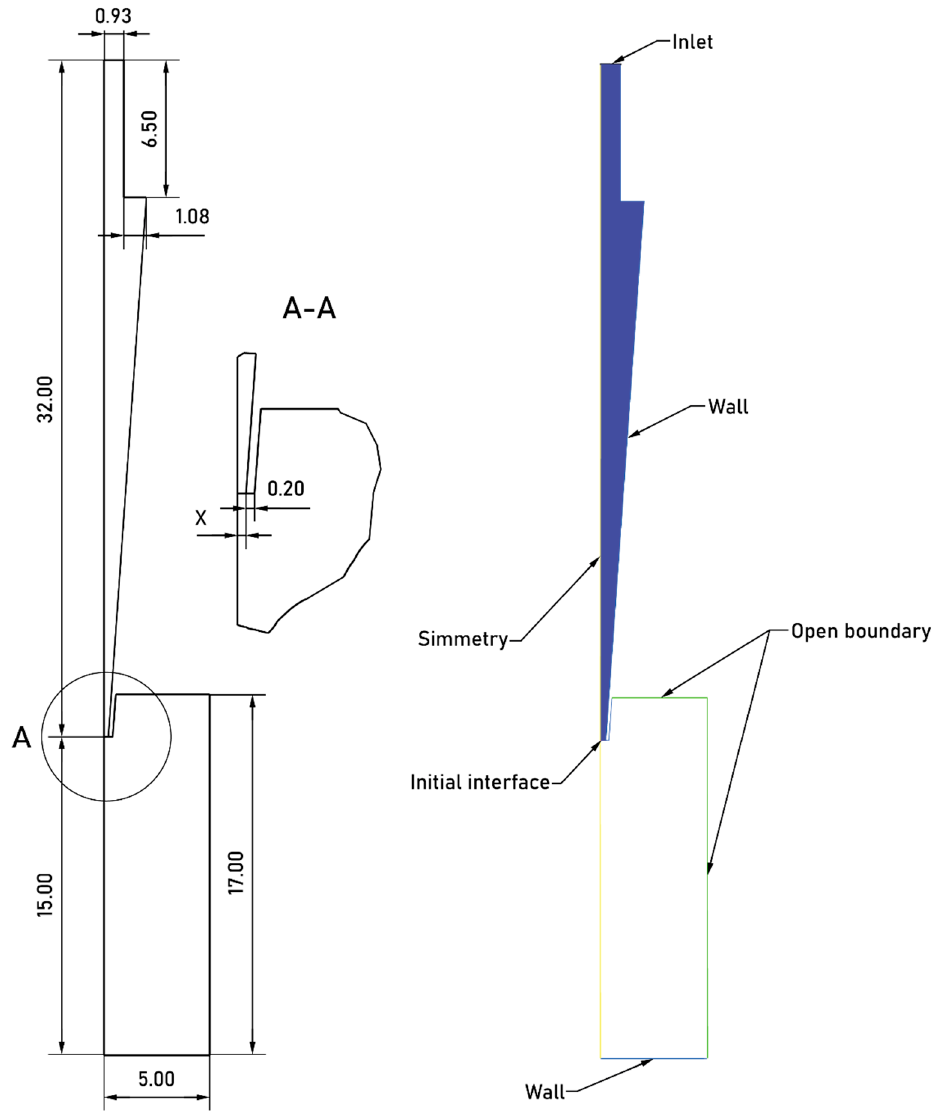
Figure 2. Representation of models’ geometry, in millimeters, based on real measures of a commercial conical tip where X = 0.30, 0.20, and 0.13 mm for 20, 22, and 25G, respectively ( right ). Representation of bioink domain (light grey) and air domain (dark grey) with all boundary conditions ( left ).